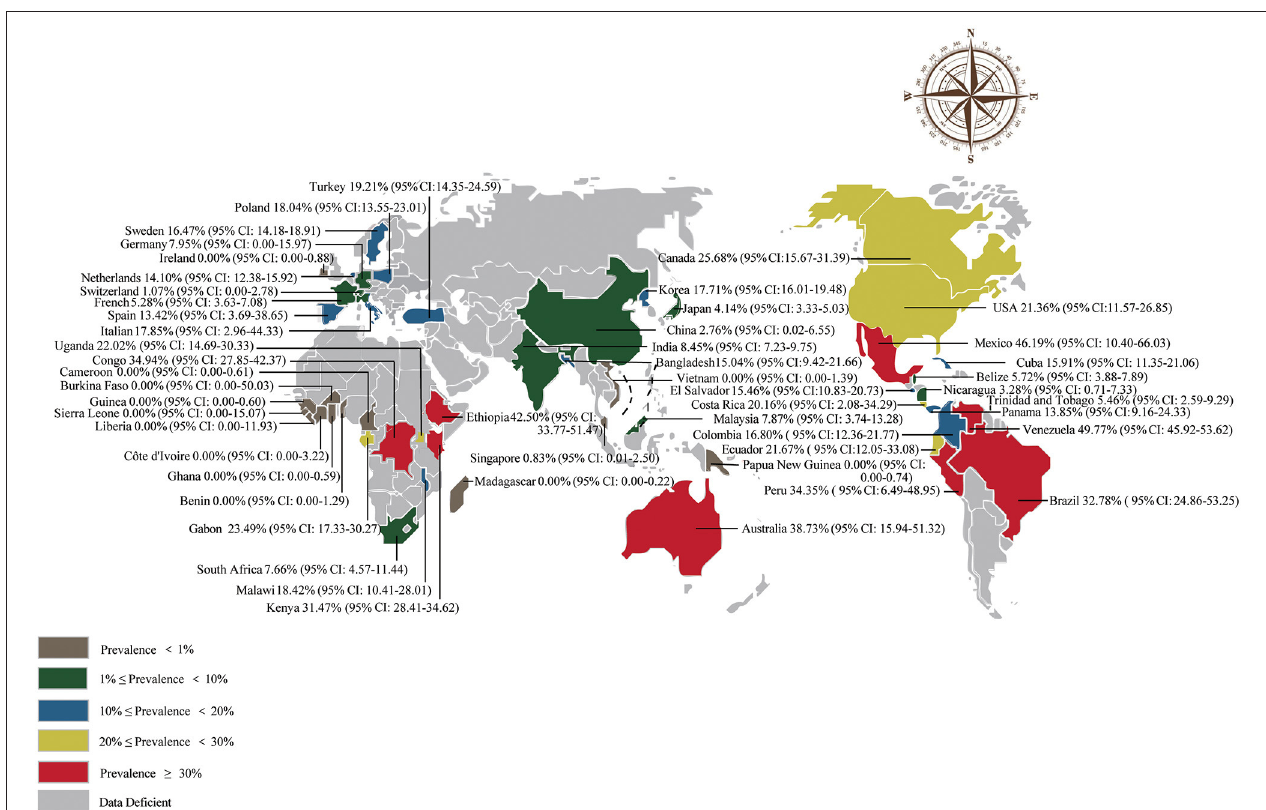
FIGURE 3 | Map of the prevalence of Batrachochytrium dendrobatidis in amphibians worldwide.